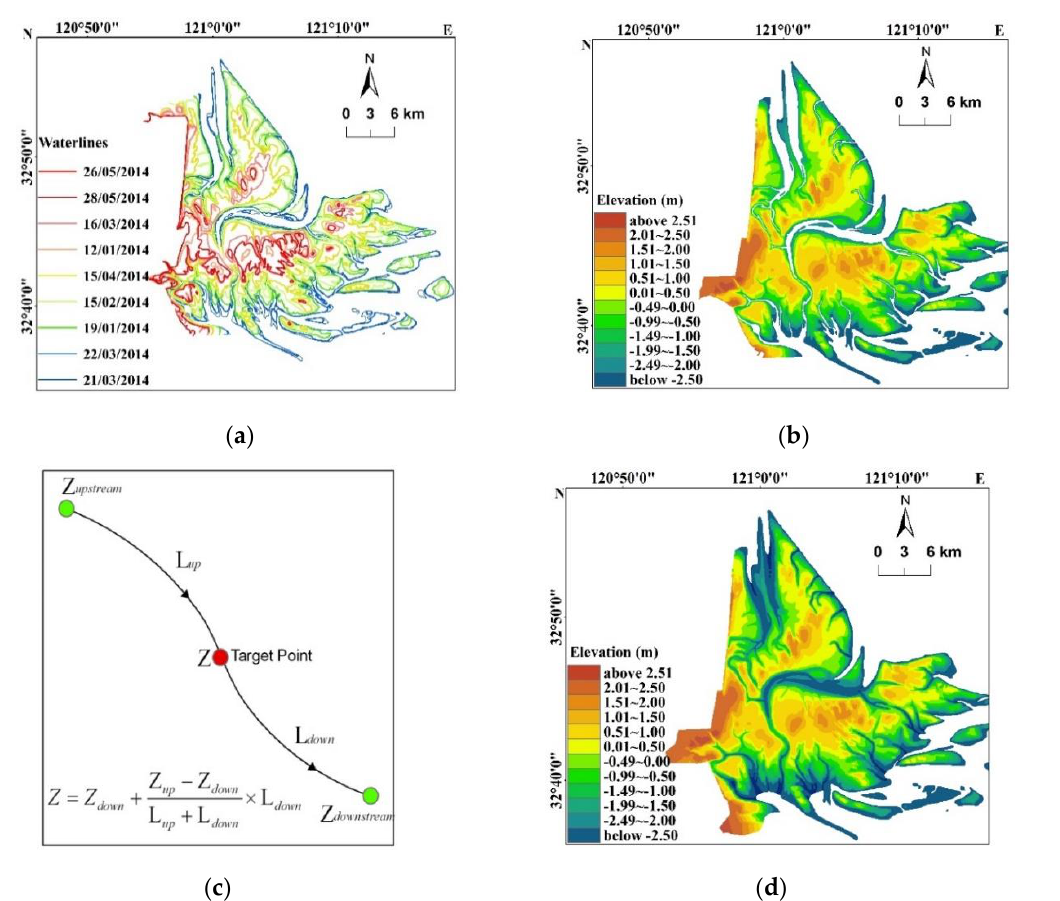
Figure 2. Height assignment to tidal creeks. ( a ) Waterlines extracted from remote images; ( b ) initial topographic map generated from the waterline method; ( c ) linear interpretation in tidal creeks; ( d ) topographic map of Tiaozini area.